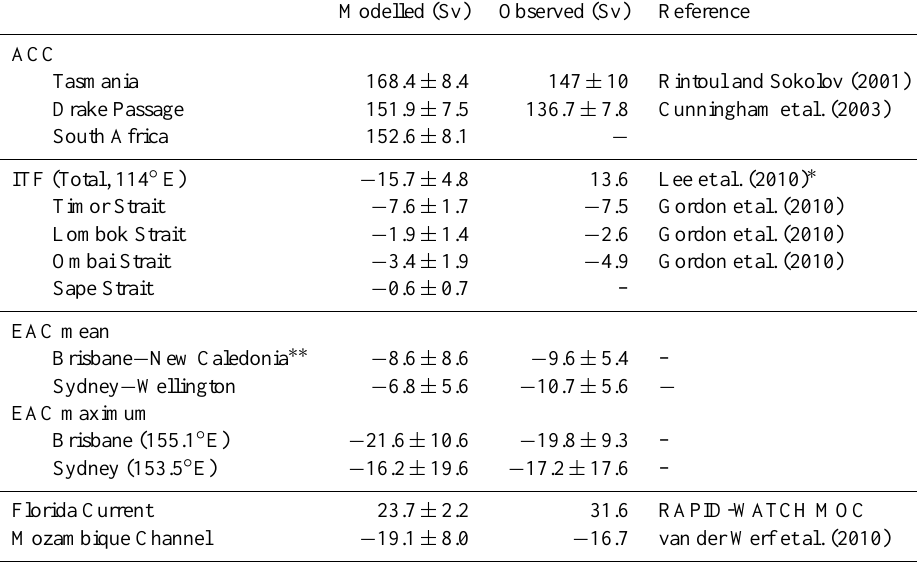
Table 2. Comparison of volume transports in key straits and passages from the model and from observations. Where error bars were available, they are included below. The errors for the model estimates are standard deviations of monthly means. The EAC transports are based on geostrophic velocities along frequently repeated expendable bathythermograph (XBT) lines and are referenced to 2000db; showing the mean and the maximum mean transport. The longitude of the maximum transport is also